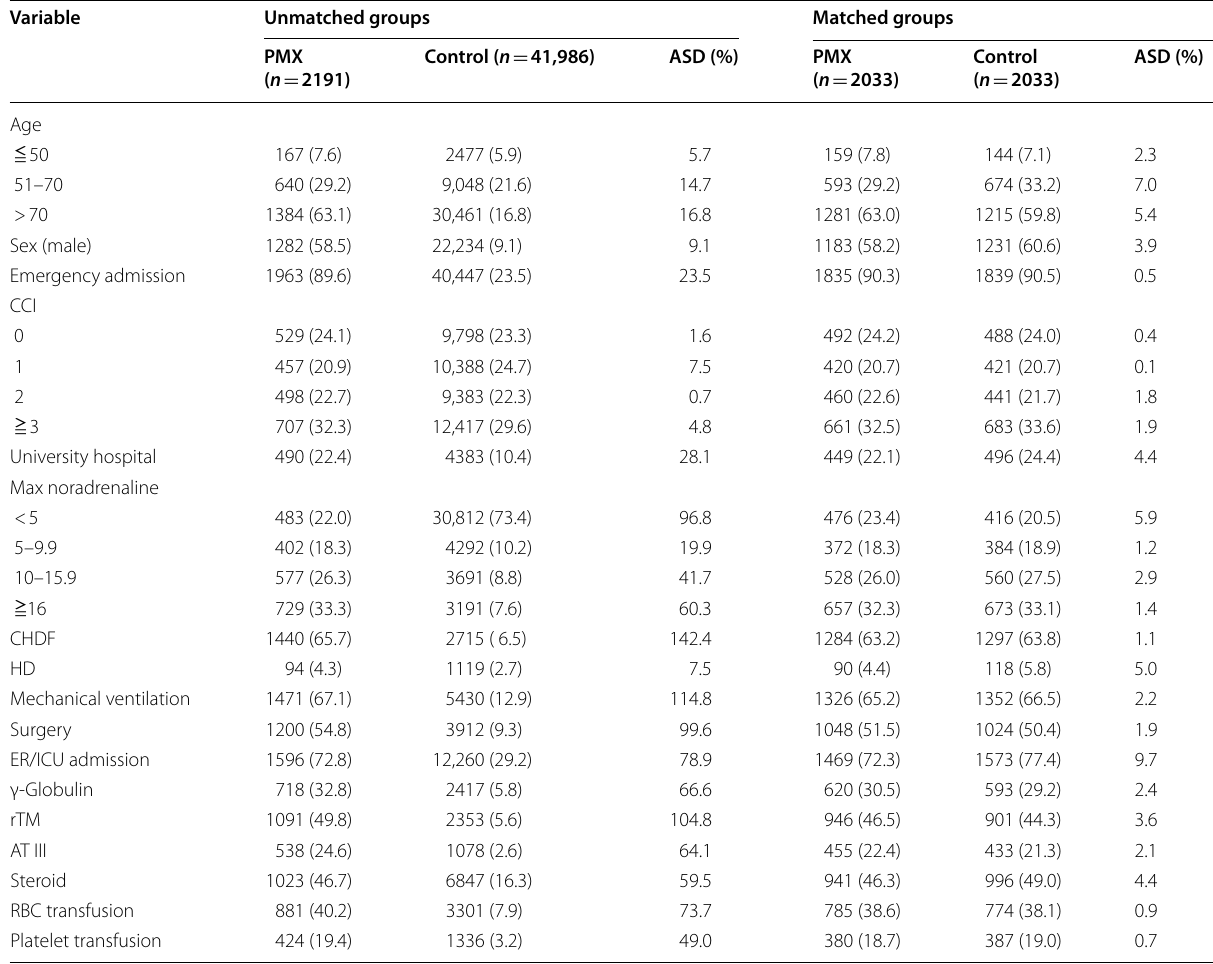
CCI Charlson Comorbidity Index, CHDF continuous hemodiafiltration, HD hemodialysis, ER emergency room, ICU intensive care unit, rTM recombinant thrombomodulin, AT antithrombin, RBC red blood